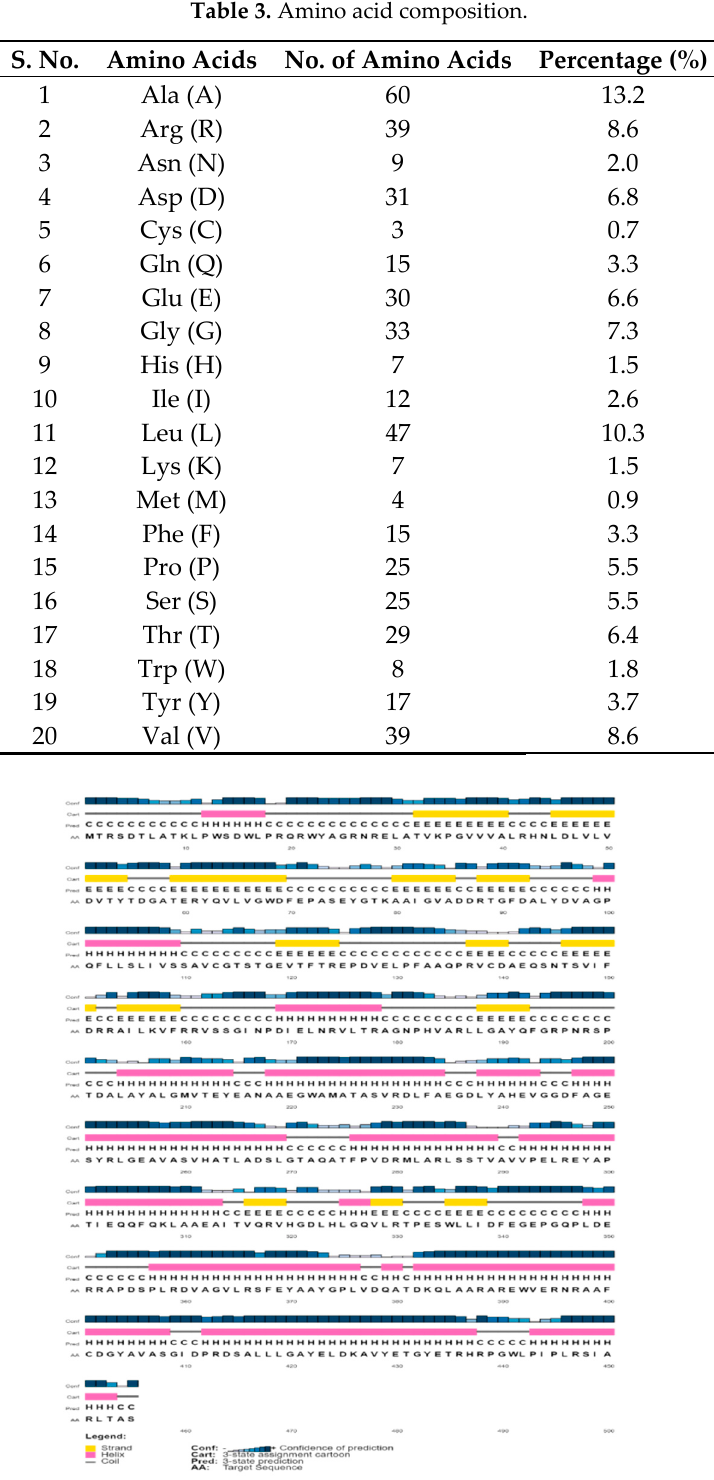
Figure 1. Predicted secondary